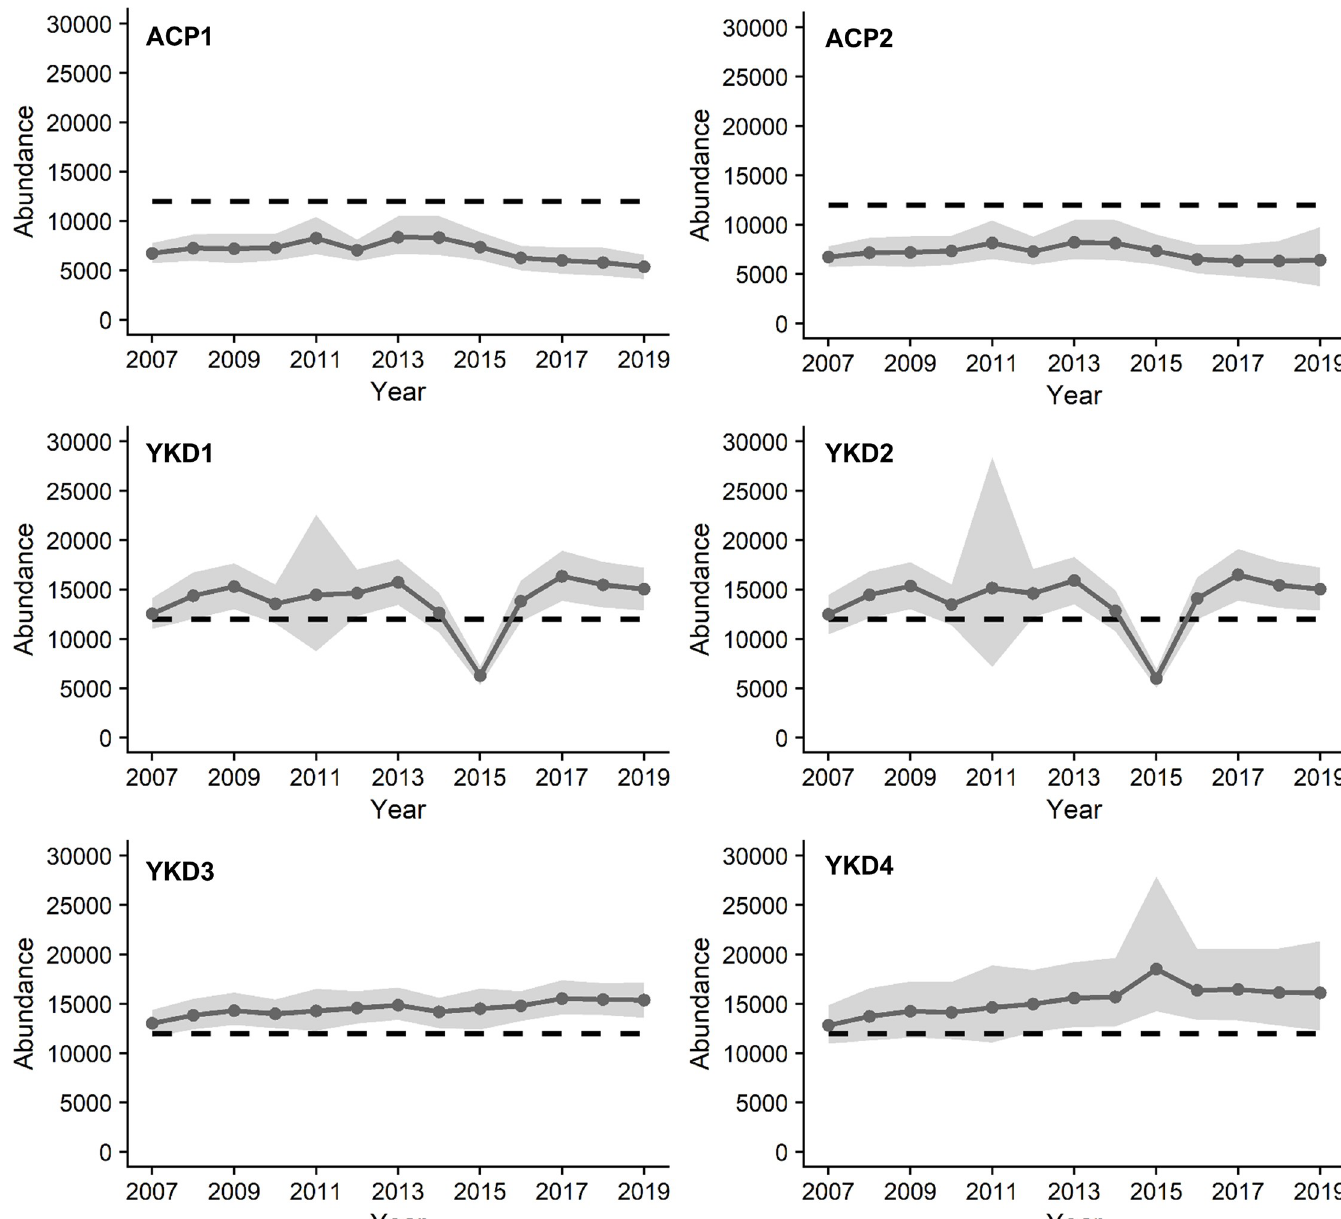
Fig 1. Posterior estimates of abundance for spectacled eider populations breeding on the Arctic Coastal Plain (ACP) and Yukon-Kuskokwim Delta (YKD) of Alaska. We fit 2 alternative models for the ACP breeding population and four alternative models for the YKD breeding population. Models ACP1 and YKD1 included all available years of data between 2007 and 2019 and were initialized with ‘informative’ priors based on the species’ biology and expert opinion. Model YKD2 included all years of data between 2007 and 2019 and was initialized using noninformative priors. Model YKD3 was fit by excluding the 2015 population estimate and initializing the model with informative priors. Finally, models ACP2 and YKD4 allowed for a latent observation process and used informative priors to provide estimates of VCF variance and an observer effect. Gray circles represent the annual mean abundance and gray ribbons represent the 95% credible interval (CRI). The black dashed line is the population threshold of 12,000 breeding birds identified in the species recovery